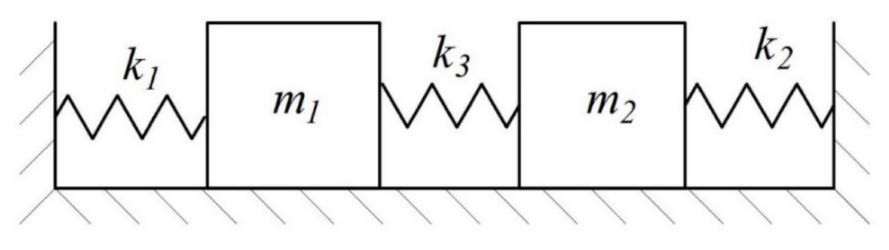
Figure 9. The equivalent model of point B and point